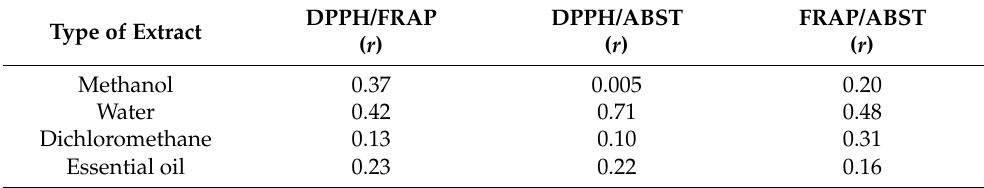
Table 2. Pearson’s correlation between antioxidant activity of solvent extracts by different antioxidant assays. DPPH/FRAP DPPH/ABST Type of Extract ( r ) ( r )